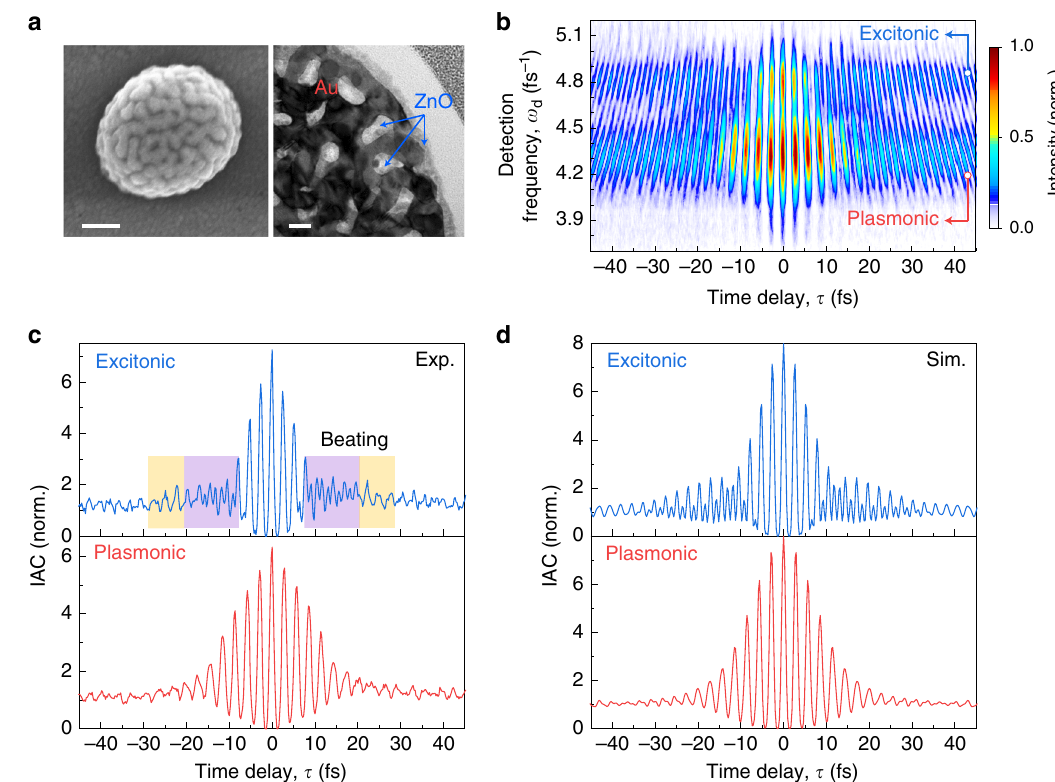
Fig. 3 Enhanced coherent excitonic emission from a single hybrid Au/ZnO nanosponge. a Scanning electron microscopy (left, scale bar: 100 nm) and cross-sectional transmission electron microscopy (right, scale bar: 20 nm) images of a hybrid Au/ZnO nanosponge. A 10-nm thick layer of ZnO has been deposited onto their outer surface and in fi ltrated into the nanopores. b IFRAC trace of a single hybrid Au/ZnO nanosponge. Two distinct emission bands can be observed: a broad nonlinear plasmonic emission at ∼ 4.3 fs − 1 and a distinctly enhanced excitonic emission at ZnO exciton frequency of ∼ 4.8 fs − 1 . c Experimental interferometric autocorrelation (IAC) traces integrated over the range of the plasmonic (bottom) and excitonic (top) emission from the IFRAC trace in b . The beating pattern showing destructive (purple region) and constructive (yellow region) interference at the excitonic emission band results from SF generation from a single hot spot. d IAC traces simulated by a nonlinear plasmon – exciton coupling model, agreeing well with the